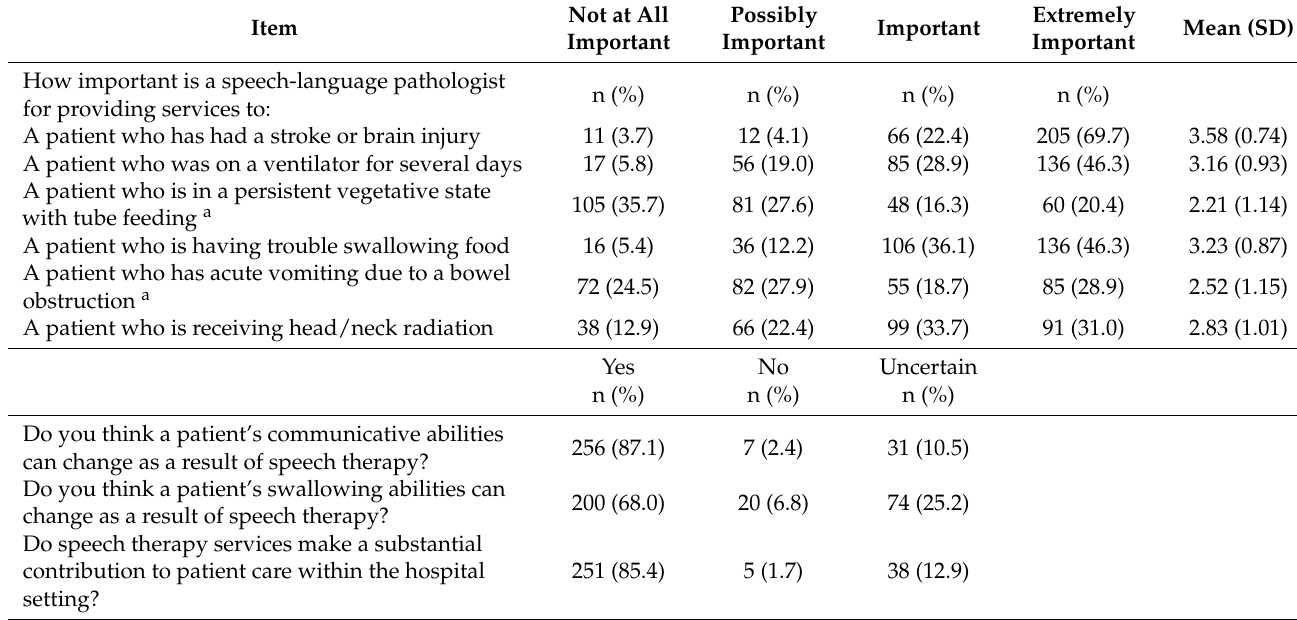
Table 2. Participants’ Perception of the Value of Speech-Language Pathology (N =